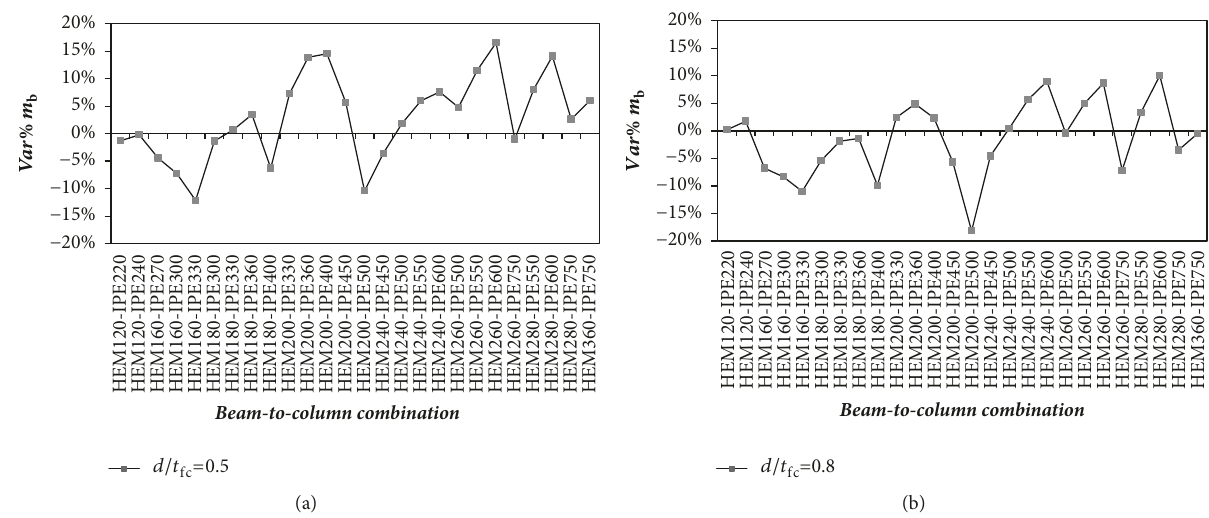
Figure 15: Accuracy of the approximate equations in terms of percentage of difference for selected values of the ratio 𝑑/𝑡 fc : normalized resistance